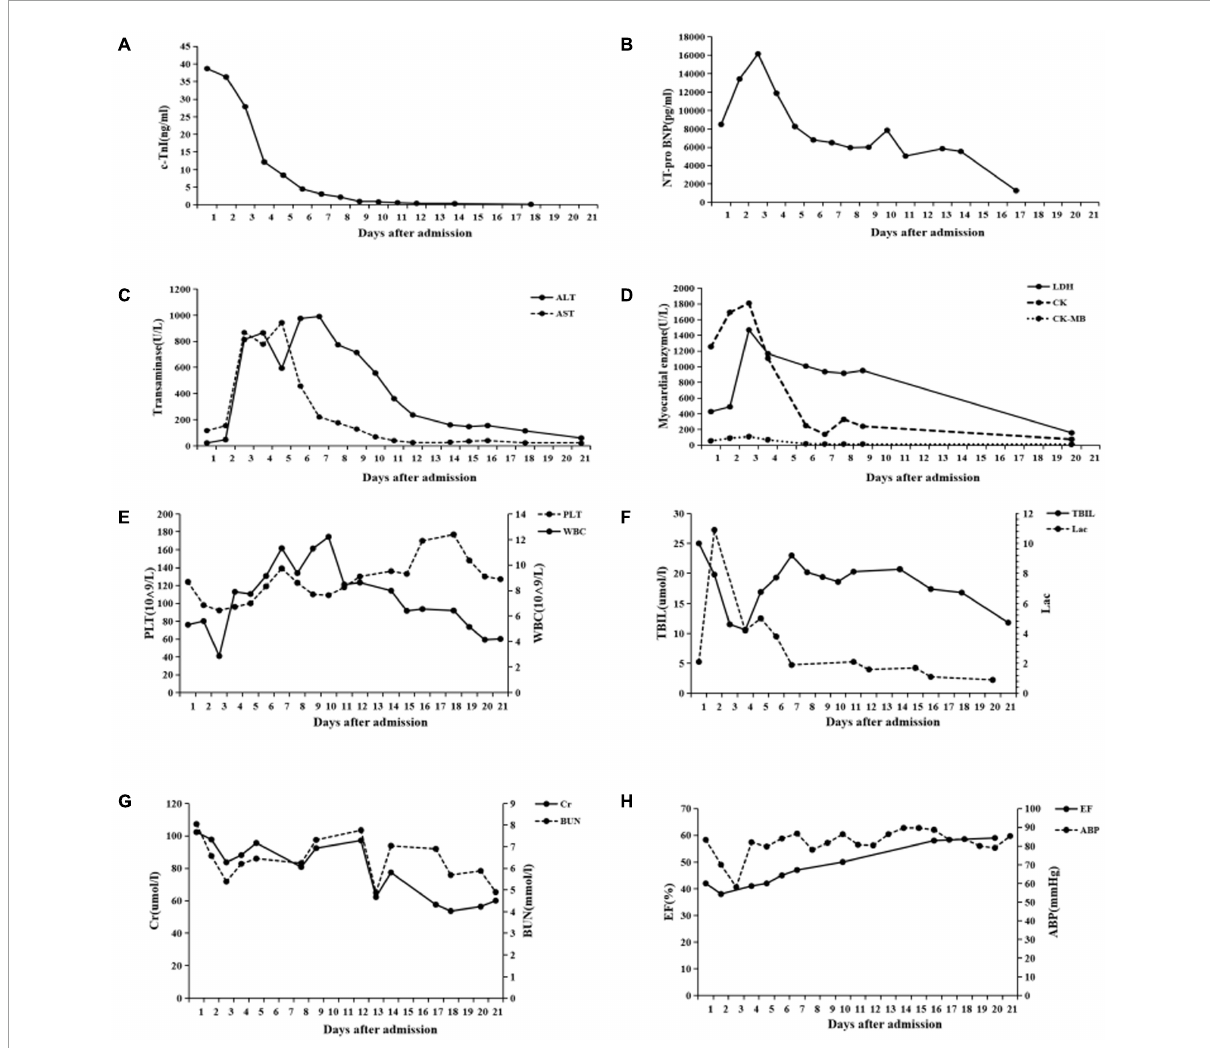
FIGURE4 Changes of various indexes during 21 days of hospitalization. (A) cTnI. (B) NT-pro BNP. (C) ALT and AST. (D) Myocardial zymogram. (E) Platelet (PLT) and leukocyte count (WBC). (F) Total bilirubin (TBIL) and arterial blood gas lactate (Lac) levels. (G) Creatinine (Cr) and blood urea nitrogen (BUN). (H) Ejection fraction (EF) and average blood pressure (ABP) in transthoracic